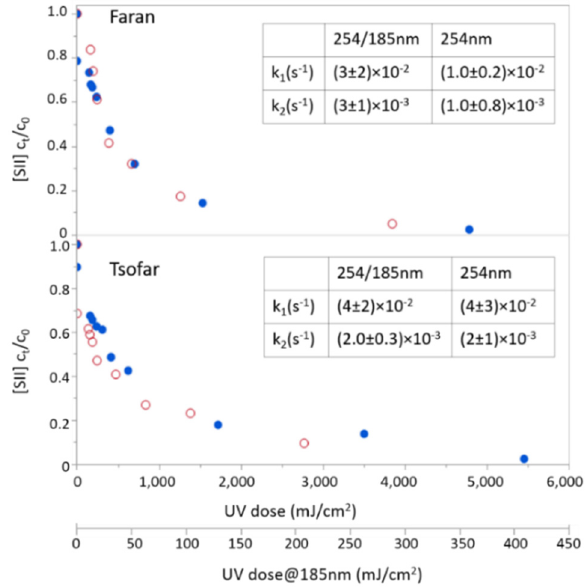
Figure 4. H 2 S removal from natural groundwater (normalized concentration to initial concentration) using a 254 nm lamp (blank red circles) and the combined 254/185 nm lamp (solid blue circles) in different radiation doses. Rate coefficients depicted in the inserts are the coefficients obtained from the double exponent fitting: [H 2 S] = a · exp( − k 1 × dose) + b · exp( − k 2 × dose). · OH consumption rates by the main substances present in the groundwater were compared in order to estimate their relative importance as · OH scavengers (Table 2). The results indicate that chloride ion was the dominant scavenger, followed by bicarbonate.